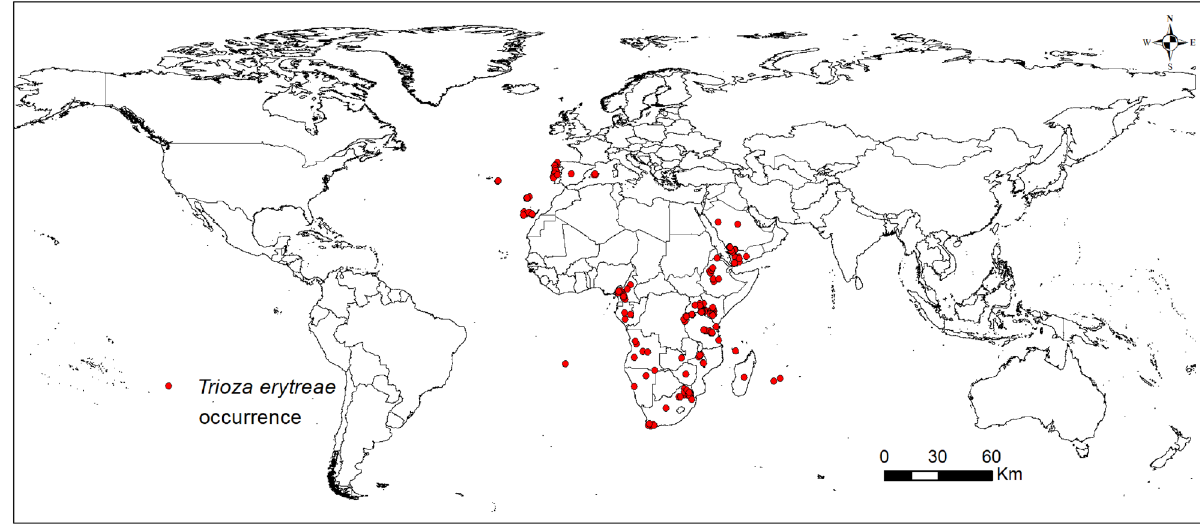
Figure 1. Known global distribution of Trioza erytreae . ESRI ArcMap 10.2.2: (https:// suppo rt. esri. com/ en/ Produ cts/ Deskt op/ arcgis- deskt op/ arcmap/ 10-2- 2# downl oads).